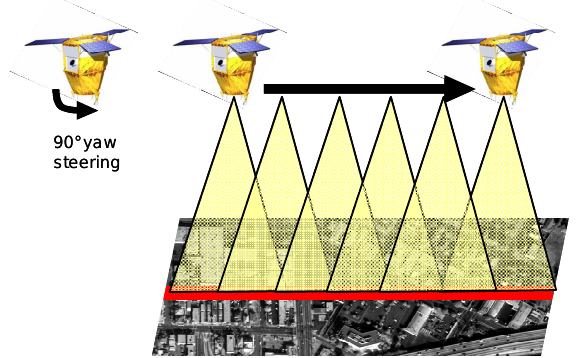
Figure 7 : AMETHIST acquisition principle